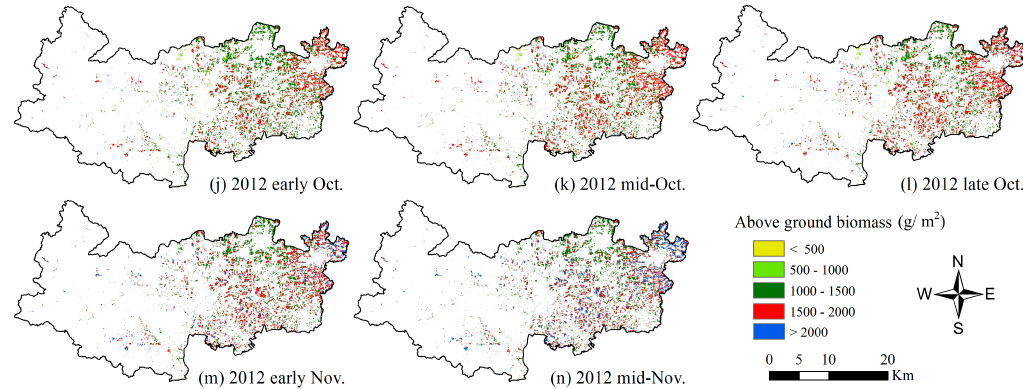
Figure 9. Dry aboveground biomass dynamic mapping of single-cropped rice in Deqing County in 2012.